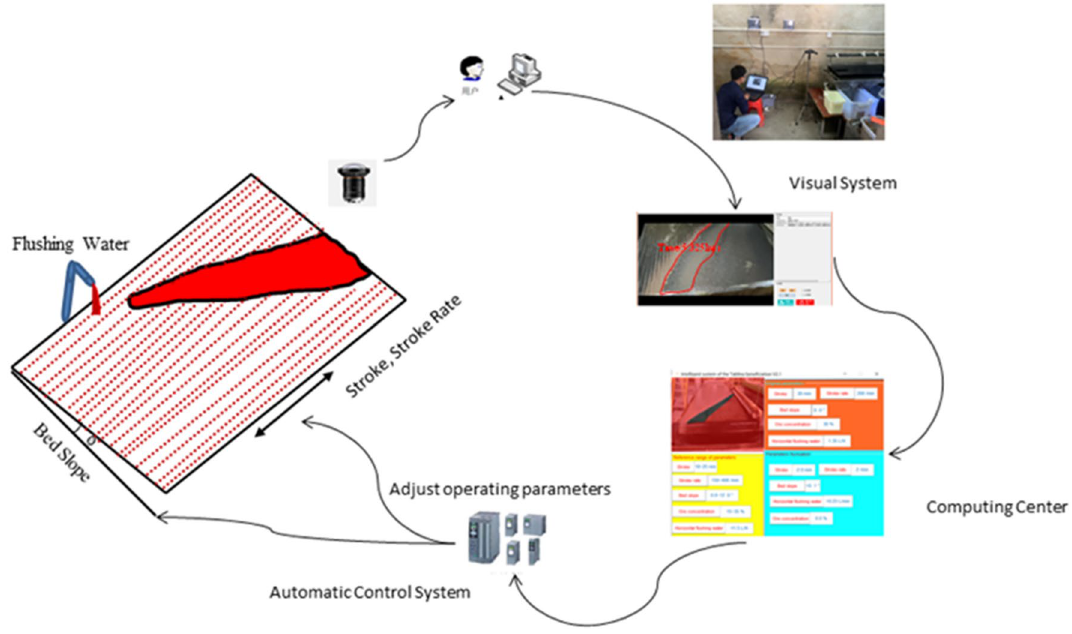
Figure 1. Experiment system for mineral separation and processing of shaking table.